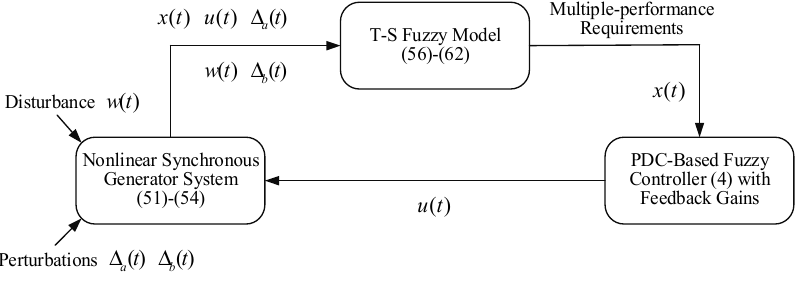
Figure 2. Block-diagram for the nonlinear synchronous generator control system.